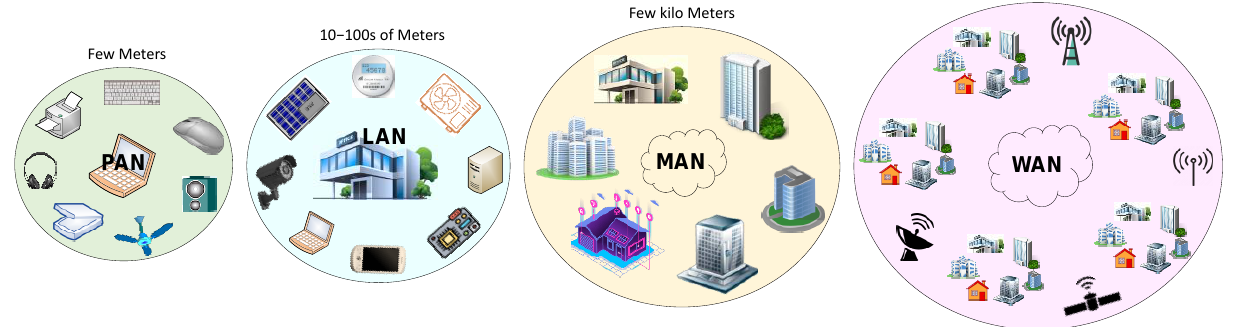
Figure 7. Elucidation of PAN, LAN, MAN, and WAN.